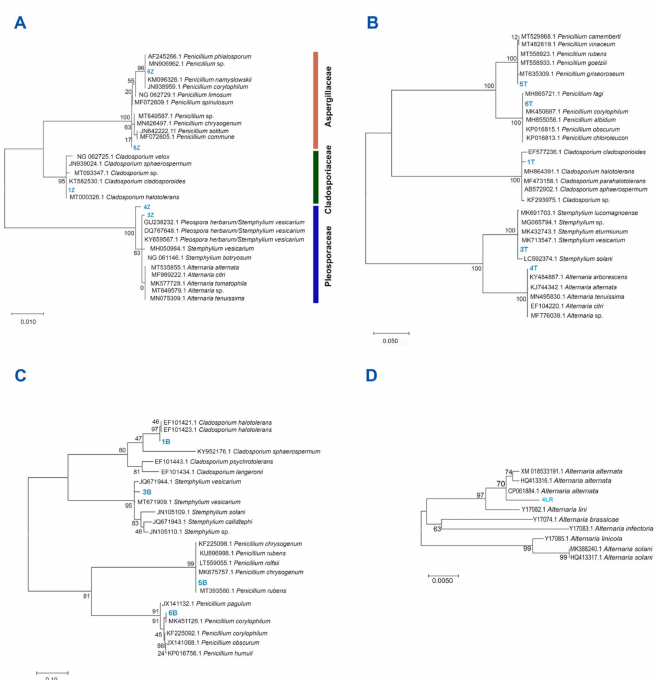
Figure 3. Evolutionary analysis by Maximum Likelihood method for ( A ) 18S, ( B ) ITS, and ( C ) β - tubulin. Bootstrap values are indicated above the branches. The phylogenetic position of deep-sea derived fungal sequences is denoted by blue color. The evolutionary history was inferred by using K2+I ( A , B ), K2+G ( C ), and HKY+G ( D ) substitution models. The tree with the highest log likelihood is shown. The initial tree for the heuristic search was obtained automatically by applying the Neighbor- Join and BioNJ algorithms to a matrix of pairwise distances estimated using the Maximum Composite Likelihood (MCL) approach and then selecting the topology with the superior log likelihood value. The tree is drawn to scale, with the branch lengths measured in the number of substitutions per